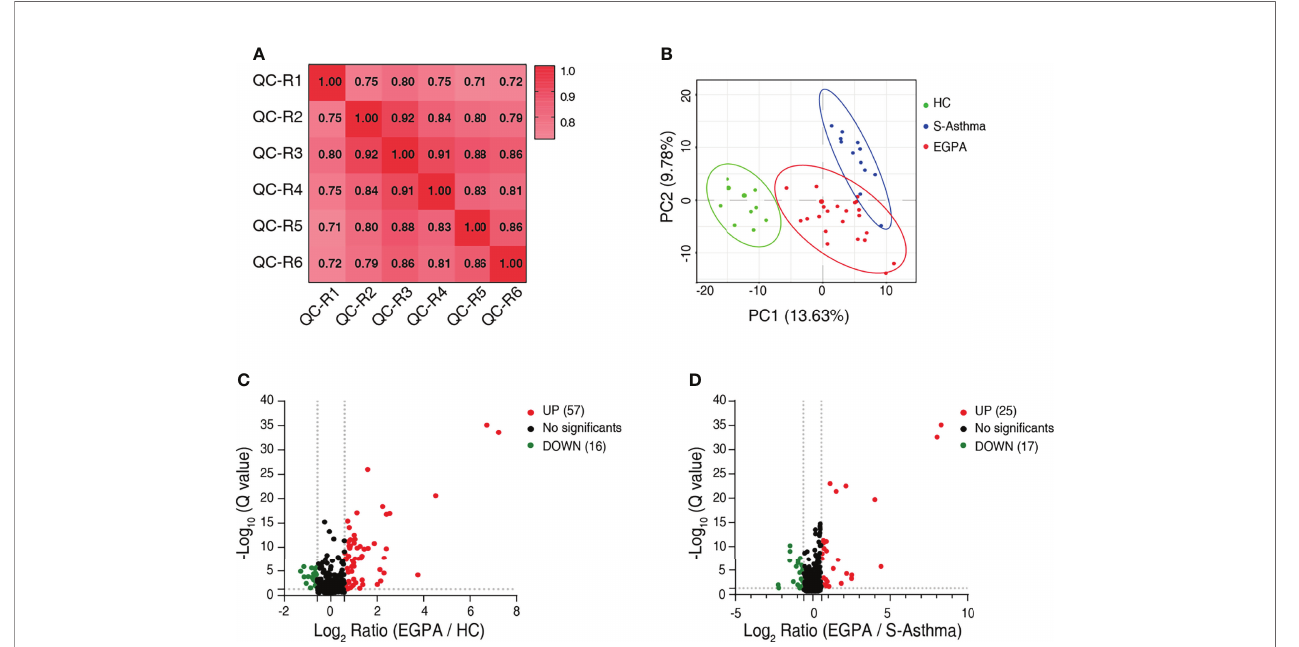
FIGURE 2 | Identi fi cation of differentially expressed proteins. (A) Correlation analysis to validate the technical reproducibility of quality control sample analysis using the DIA approach. (B) PCA score plot of the serum samples of discovery cohort showing clear separation of healthy controls from severe-asthma and EGPA patients. (C) Volcano plot shows the DEPs between EGPA and healthy control groups. (D) Volcano plot shows the DEPs between EGPA and severe-asthma groups. Green dots indicate downregulated proteins, red dots indicate upregulated proteins, and the black dots indicate the proteins with no signi fi cant difference. DIA, data-independent acquisition; PCA, principal component analysis; EGPA, eosinophilic granulomatosis with polyangiitis; DEPs, differentially expressed